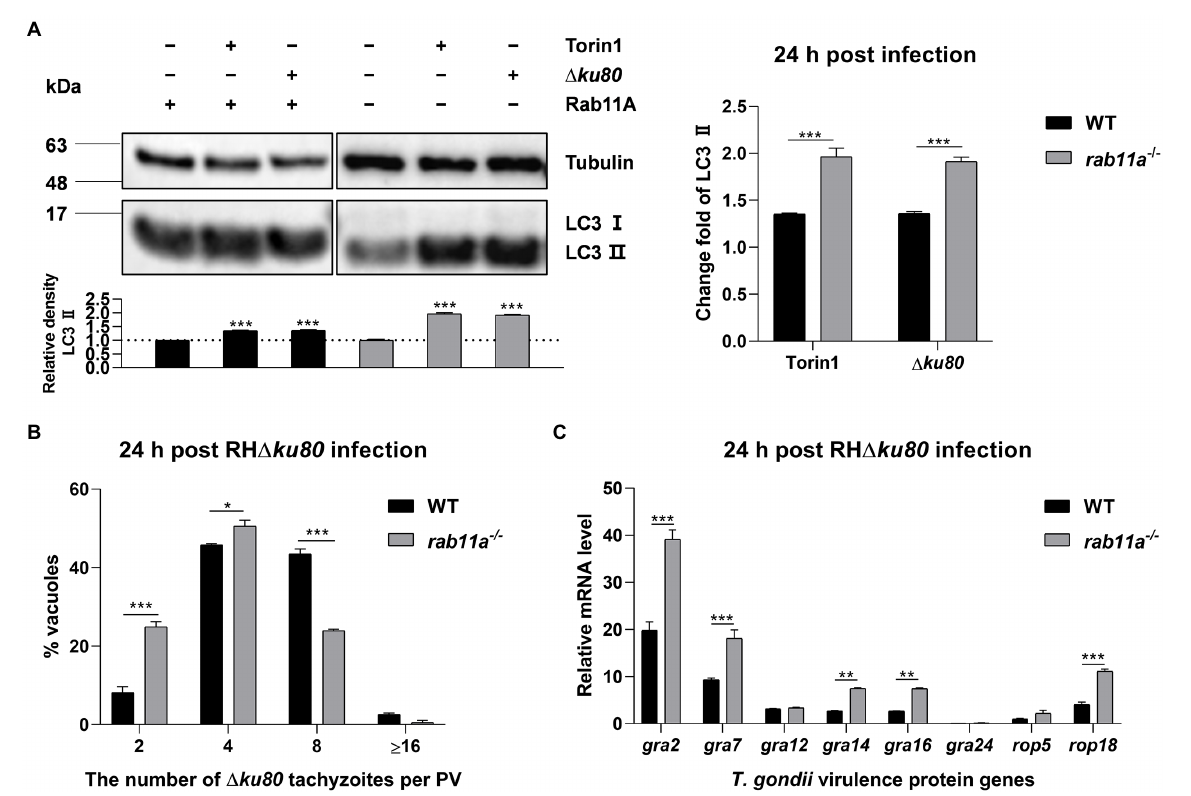
FIGURE 7 Rab11A deficiency aggravates T. gondii -induced host cell autophagy and limits T. gondii replication. (A) Wild-type and rab11a − / − HeLa cells were challenged by T. gondii RH ∆ ku80 tachyzoites at an MOI of 2:1, and cells were harvested and prepared at 24 h post-infection. Proteins of equal amounts of cell lysates were separated on 15% SDS-PAGE gels. LC3 (16 ~ 18 kDa) and p62 (~62 kDa) were detected using rabbit anti-LC3 monoclonal antibody and rabbit anti-p62 monoclonal antibody, and Tubulin (~55 kDa) was detected using mouse anti- β -tubulin